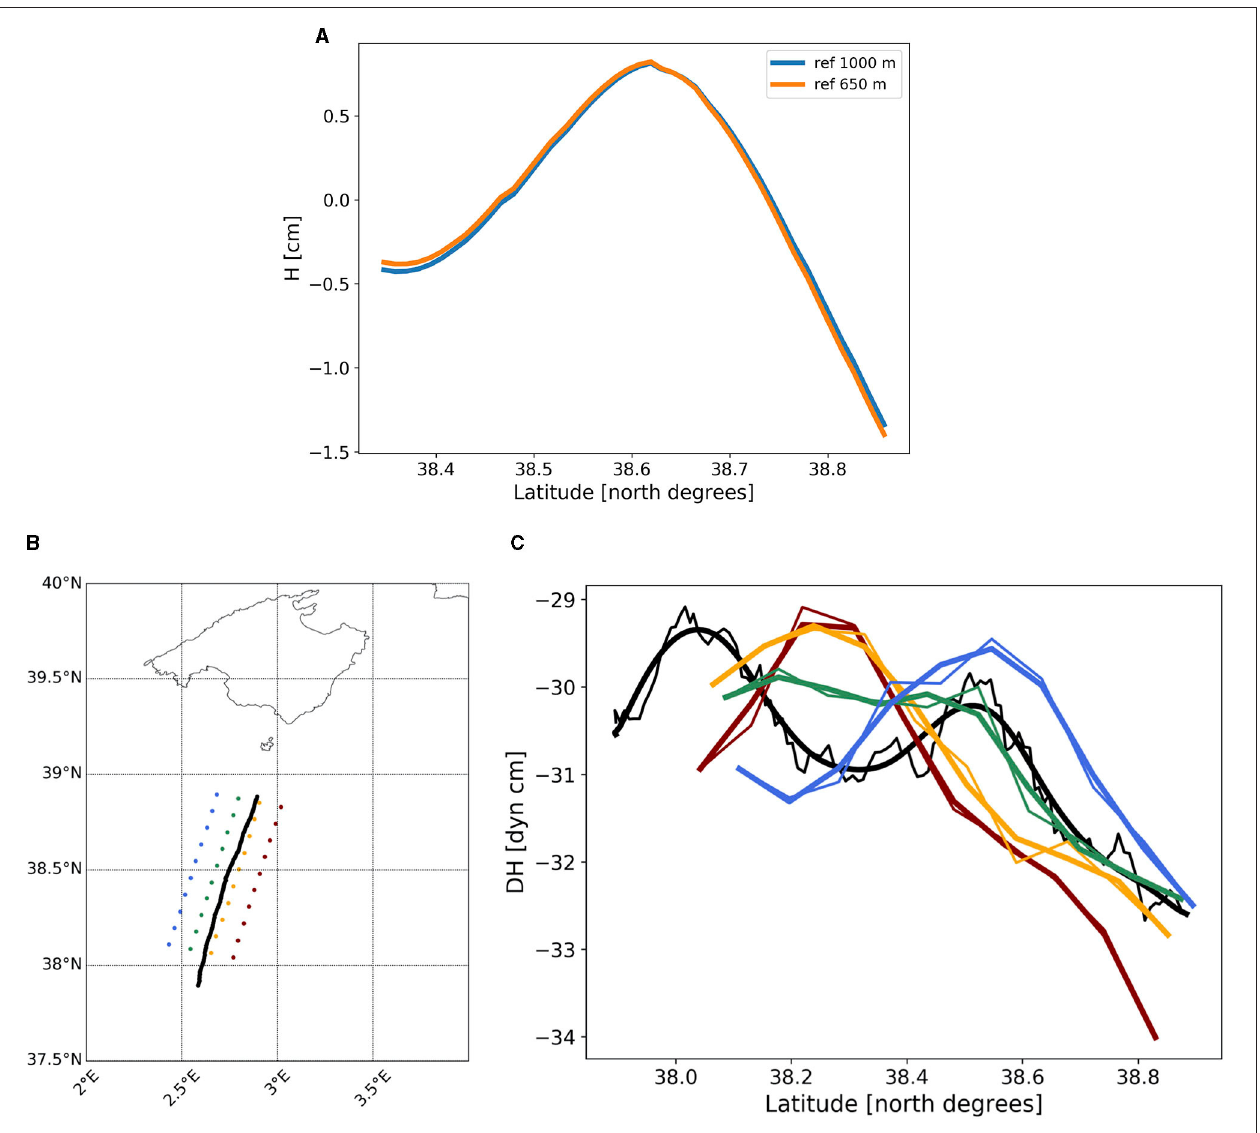
FIGURE 12 | (A) DH computed from the optimally interpolated CTD data (Leg 1) interpolated onto the glider track and assuming a reference level of 1,000 dbar (blue line) and 650 dbar (orange line). The mean values of DH are subtracted for the comparison. (B) CTD casts collected during Leg 2 along four transects parallel to the glider track (black line, 9–14 May 2018): transect 1 (red dots, 16 May 2018), transect 2 (yellow dots, 15 May 2018), transect 3 (green dots, 14–15 May 2018), and transect 4 (blue dots, 13–14 May 2018). (C) DH computed from glider (black line) and CTD data (same color code as in B ), both computed assuming a reference level at 500 dbar and smoothed with a 30 km low-pass Loess filter. Thin lines show DH computed using the unfiltered glider and CTD data.